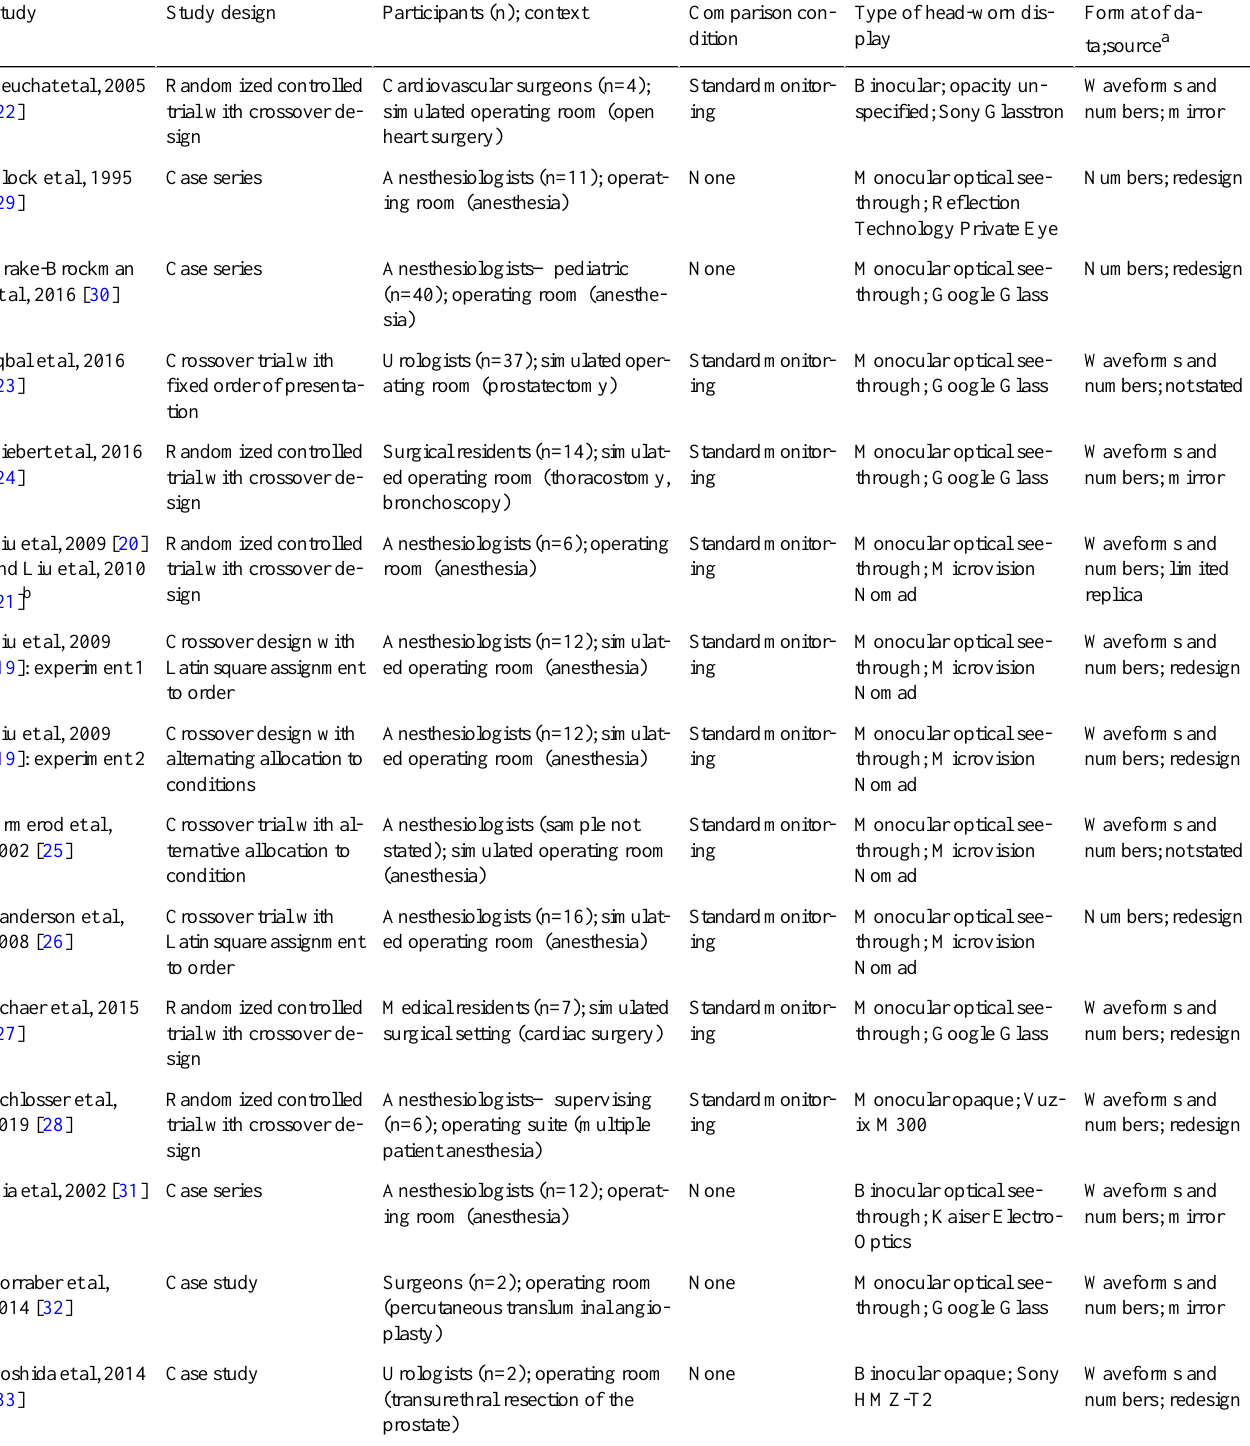
Table 1. Summary of the studies